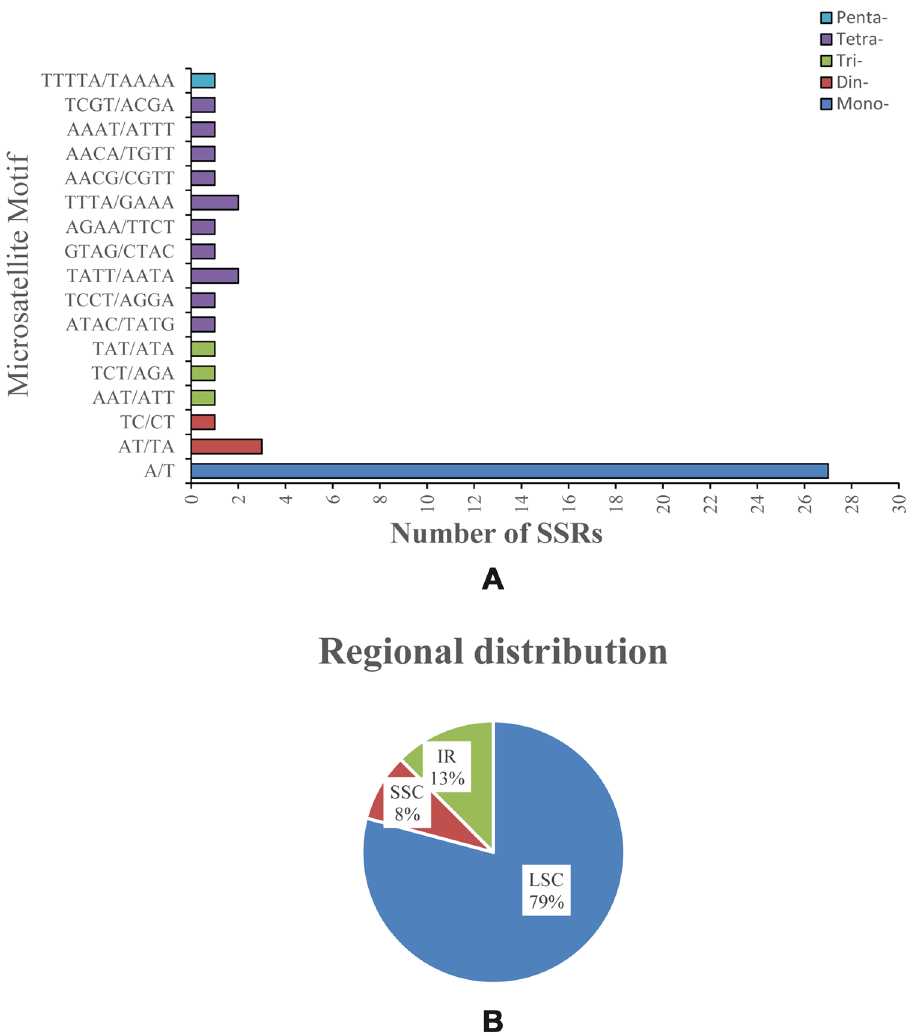
Figure 2. Analysis of simple sequence repeats in C. hirtinoda cp genome. ( A ) The percentage distribution of 45 SSRs in LSC, SSC, and IR regions. ( B ).